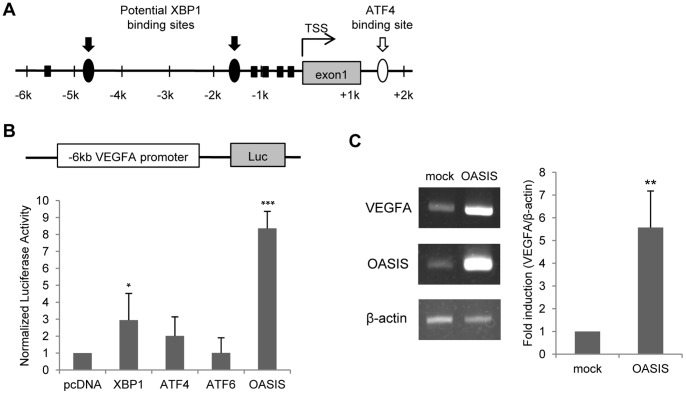
OASIS promotes the transcription of VEGFA.(A) Schematic diagram of the human VEGFA promoter region. The first intron of the human VEGFA gene contains an ATF4-binding site (○), and that the 6-kbp 5′-upstream promoter has two potential binding sites for XBP1 (•) and CRE-like sites (▪). TSS: transcription start site. (B) Reporter assays using ARPE-19 cells. A reporter vector derived from the 6-kbp 5′-upstream region of the human VEGFA gene and expression vectors for XBP1, ATF4, ATF6, or OASIS were co-transfected. At 48 h after the transfection, luciferase activities were measured. Data are means ± SD (n = 4). *p<0.05, ***p<0.001, by Student’s t-test. (C) RT-PCR analysis of VEGFA in ARPE-19 cells infected with an adenovirus vector carrying OASIS. The right panel shows the results of real-time RT-PCR. The VEGFA mRNA expression level is increased by 5.5-fold after the transfection of OASIS. Data are means ± SD (n = 3). **p<0.01, by Student’s t-test.